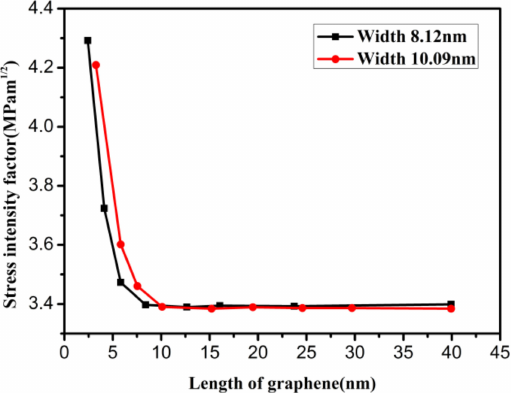
Figure 7. The variations of mode I critical stress intensity factor with increasing graphene